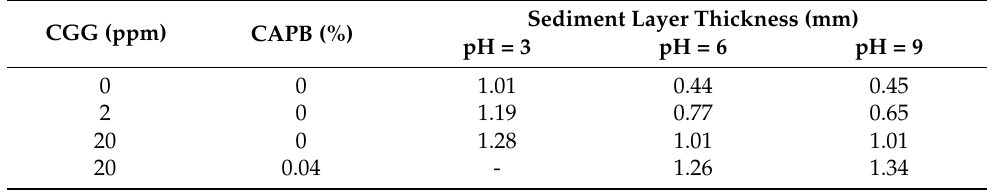
Table 2. The influence of the pH and the CGG concentration on the sediment layer thickness in the studied systems after 1